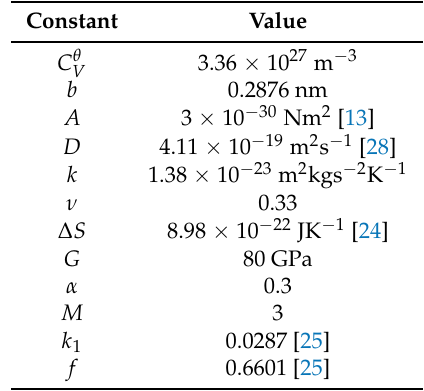
Table 2. Values of the material constants used for